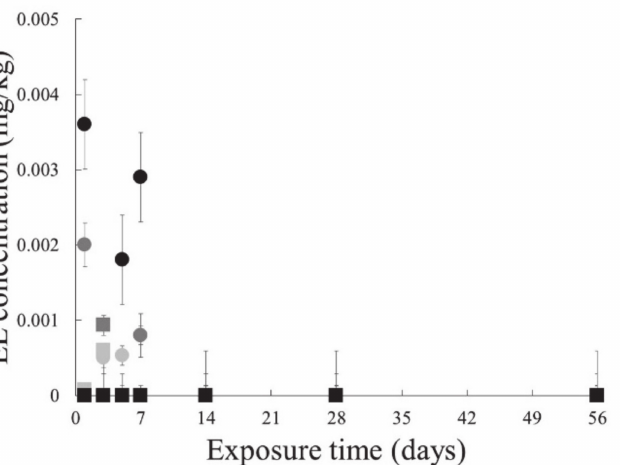
Figure 6. Endosulfan Lactone (EL) concentration for 5( (cid:4) ) and 10( • ) earthworms in sterile solid substrate with 0.001 mg/kg ( (cid:4) , • ), 0.004 mg/kg ( (cid:4) , • ) and 0.009 mg/kg ( (cid:4) , • ).